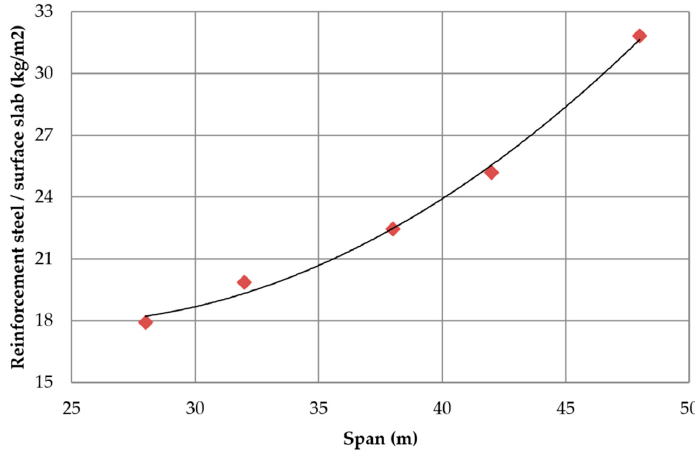
Figure 14. Variation in the ratio of the reinforcement steel in relation to the surface of the slab with the span.